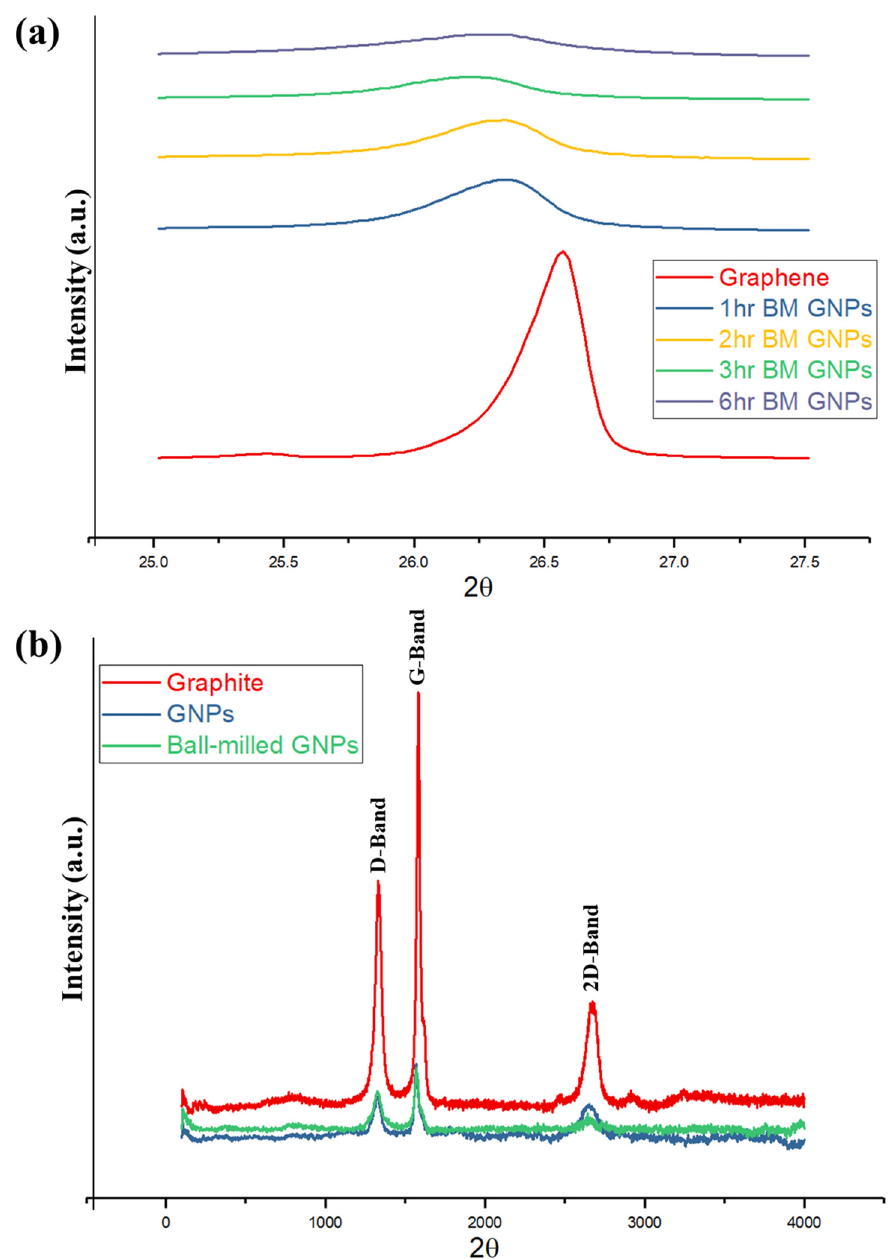
Figure 1. ( a ) X-ray diffraction pattern for graphite nanoplatelets (GNPs) before and after ball mill- ing for 1, 2, 3, and 6 h. ( b ) Raman spectra of graphite, GNP, and ball-milled GNPs tribological